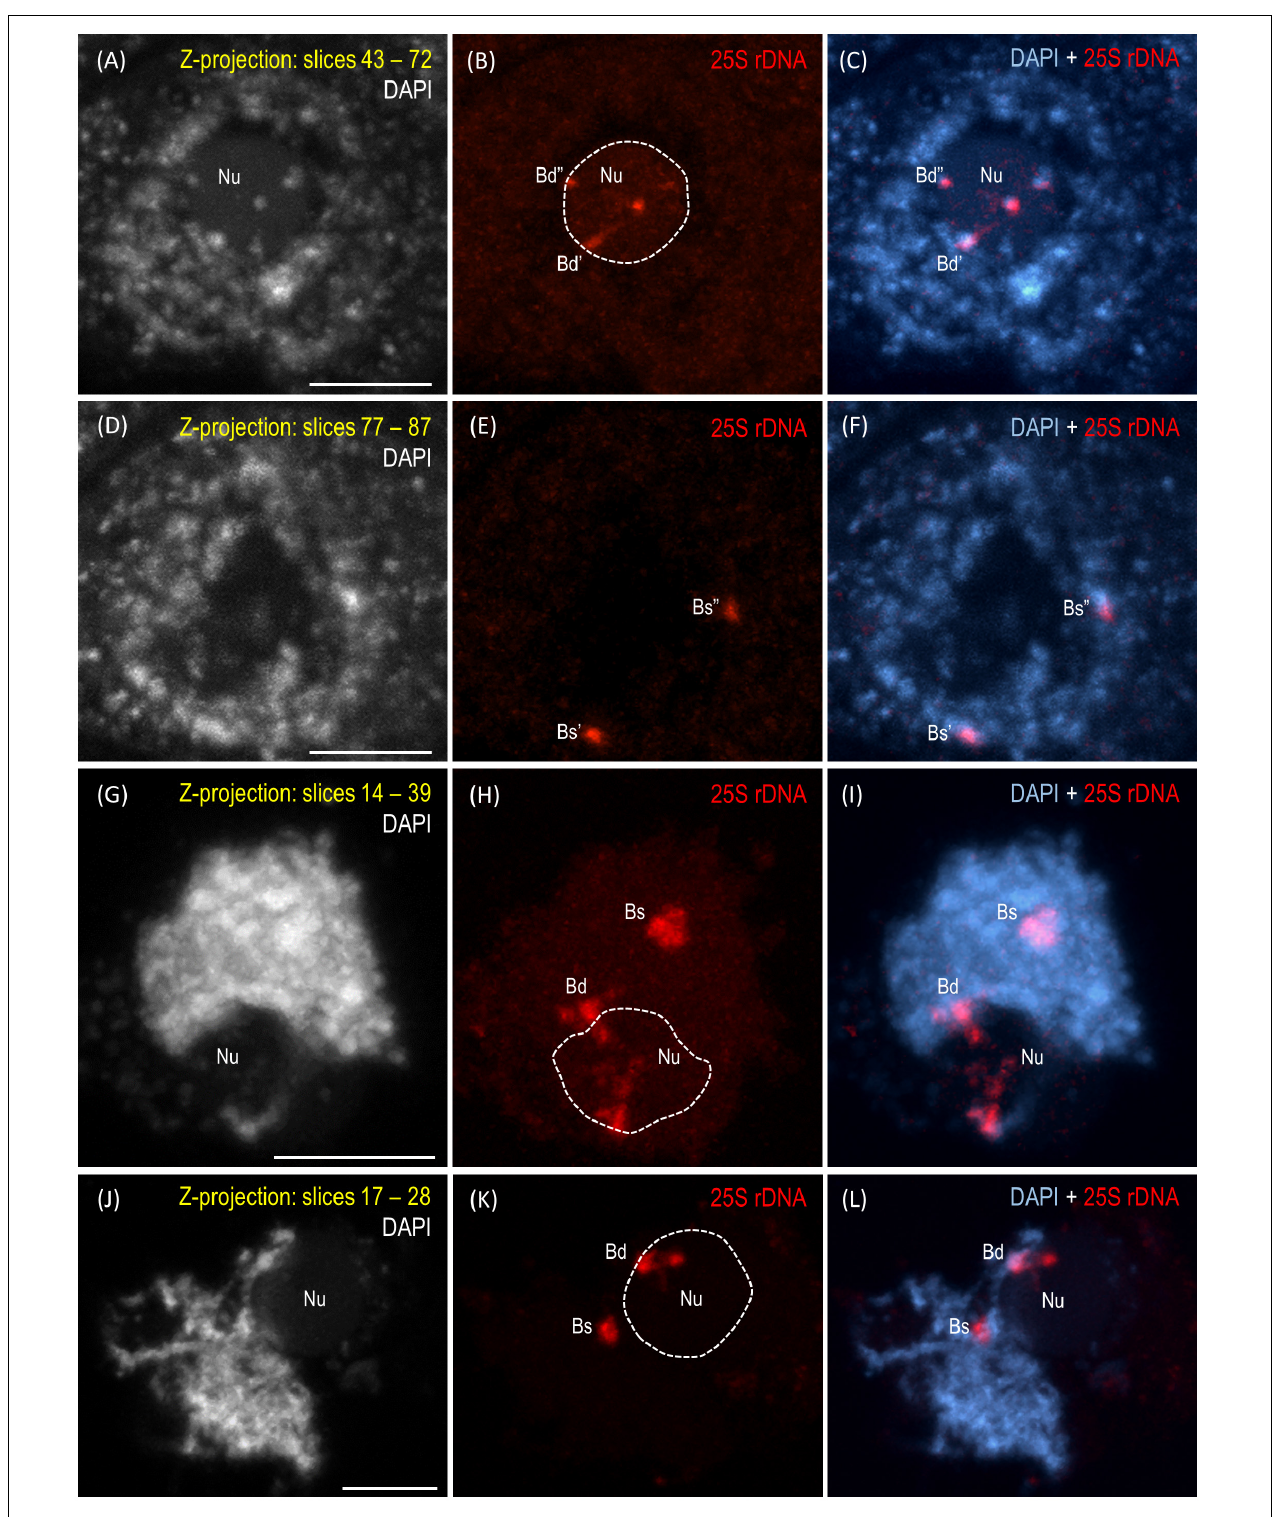
FIGURE 4 | Localization of the B. distachyon - and B. stacei -originated 35S rDNA loci in 3-D cytogenetic preparations of B. hybridum meiocytes (genotype 3-7-2) at leptotene, zygotene, and pachytene. Selected stacks that contain the 25S rDNA hybridization signals (red fluorescence) are presented. (A–F) Two different sections of one nucleus at leptotene. (G–I) Zygotene. (J–L) Zygotene/Pachytene. Bd, B. distachyon -inherited 35S rDNA loci; Bs, B. stacei -inherited 35S rDNA loci; Nu, nucleolus. The position of the nucleolus in the 25S rDNA channel (B,E,H,K) is denoted by a dashed line. Chromatin was counterstained with DAPI. Scale bar = 5 µ m.